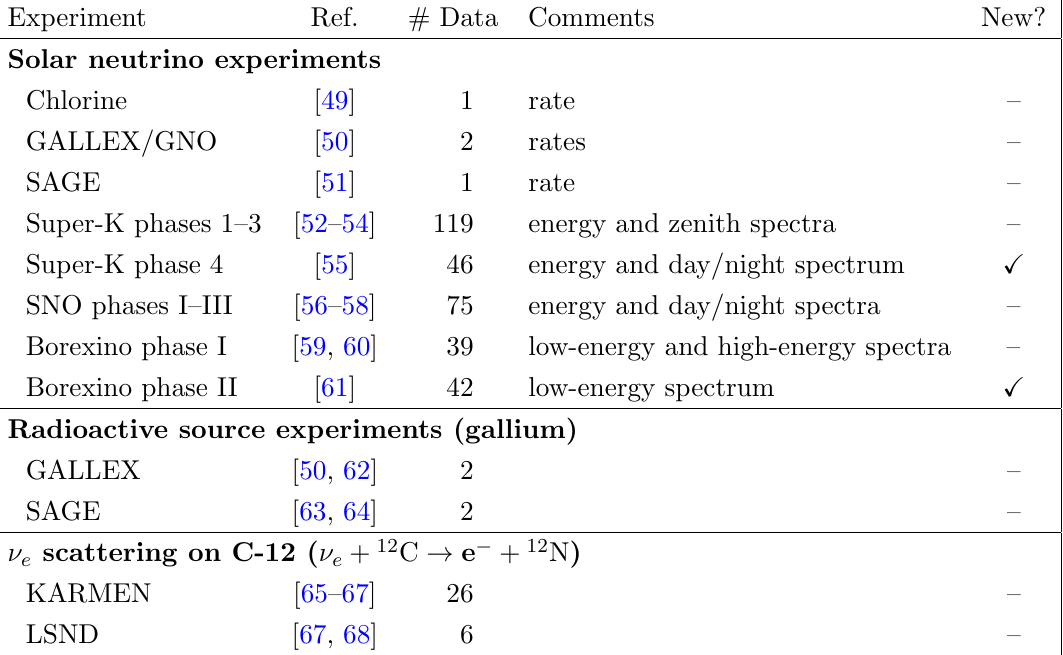
+ 12 C ! e (cid:0) + 12 N ) e